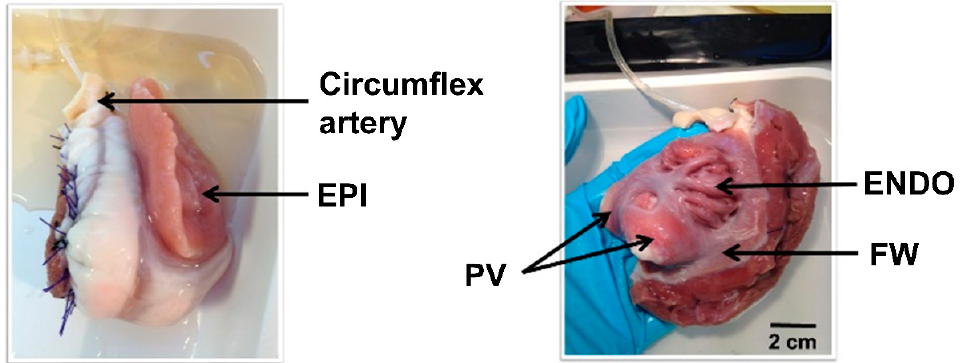
Figure 3. Langendorff left atrial preparation. Perfusion through the circumflex artery after suture of the leaky branches was performed to be able to dissociate atrial cardiac myocytes from epicardium (EPI), endocardium (ENDO), Free Wall (FW) and pulmonary vein (PV) regions. Cells were stored in a low Ca 2+ solution (0.75 mM) at room temperature and used within 8 h after isolation. Cardiomyocyte isolation was performed at 37 ± 1 ◦